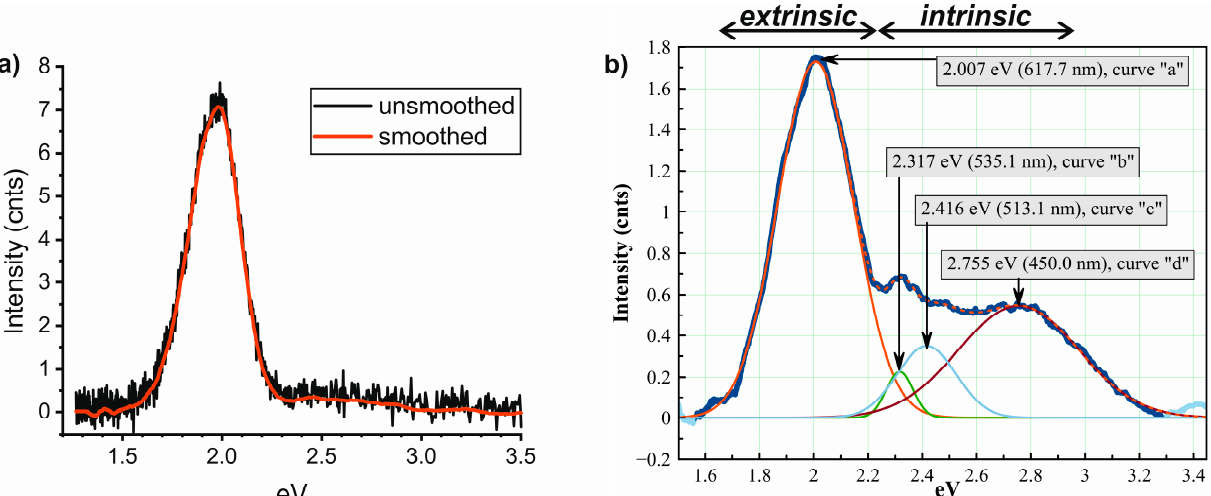
Figure 2. Examples of CL-spectra of calcite with both scales converted with respect to photon energy: ( a ) smoothed vs. unsmoothed spectrum; ( b ) fitting of the smoothed spectrum with several Gaussian curves. The curve “a” corresponds to the main CL-band of extrinsic nature (centred at 618 nm). The curves “b, c, d” (centred around 535, 513 and 450 nm, respectively) resulted from the deconvolution of the wide peripheral CL band of intrinsic nature. Note that the main CL-band is sufficiently fitted with single Gaussian curve. The difference between the position of the maximum of smoothed data (617.9 nm) and the maximum of the single Gaussian cure (617.7 nm); curve “a” is, in this case, statistically indistinguishable.